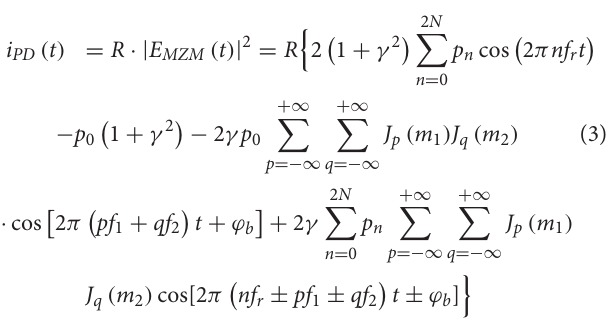
converted into electrical domain, which can be written